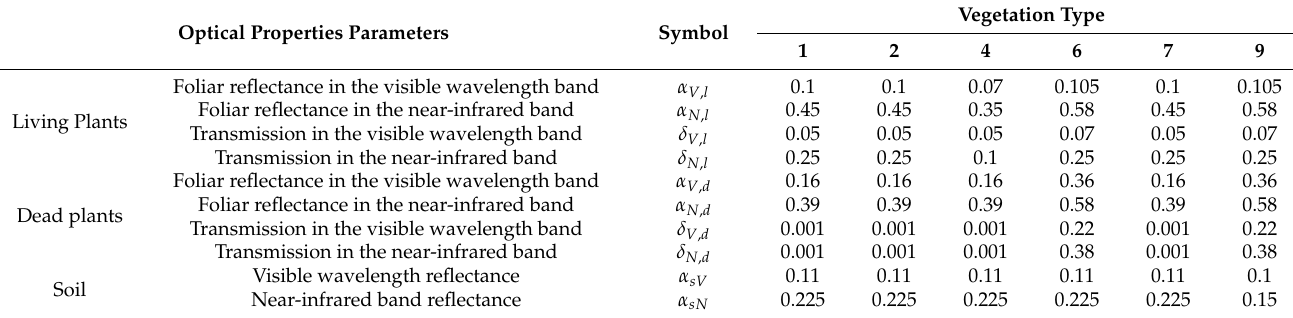
Table A4. Vegetation optical properties parameters.